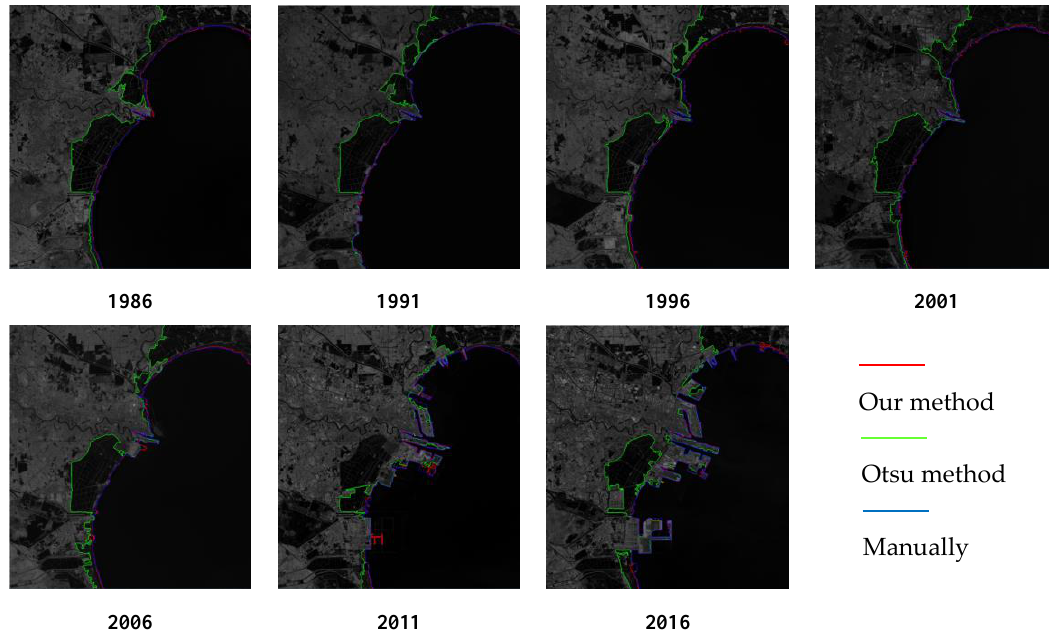
Figure 3. The coastline position detected by different